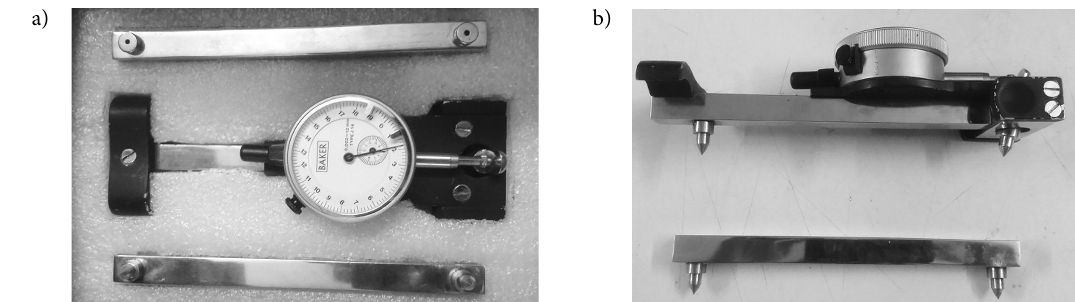
Fig. 6. Demountable mechanical strain